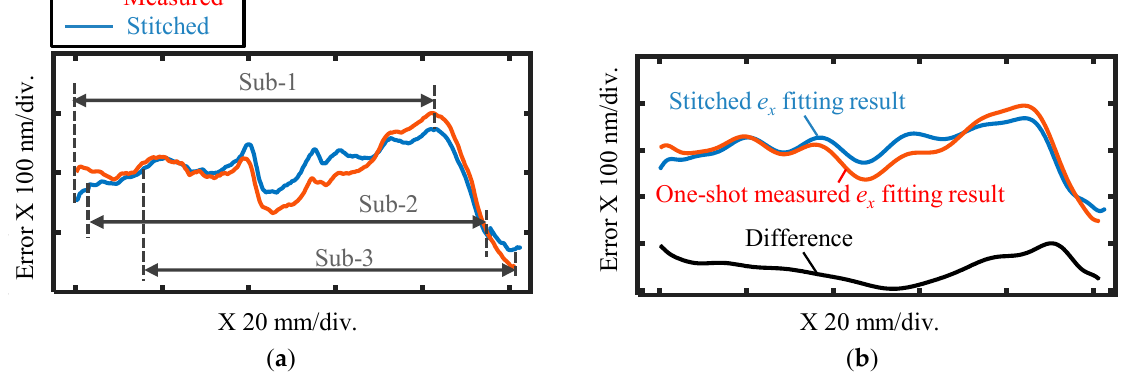
Figure 15. Comparison of the X -directional averaged cross-sections of the measured and stitched pitch deviation through one-shot and three-shot measurements. ( a ) X -directional averaged cross-section of the measured and stitched pitch deviation results; ( b ) Reconstruction results of the two averaged pitch deviation cross-sections and their difference.